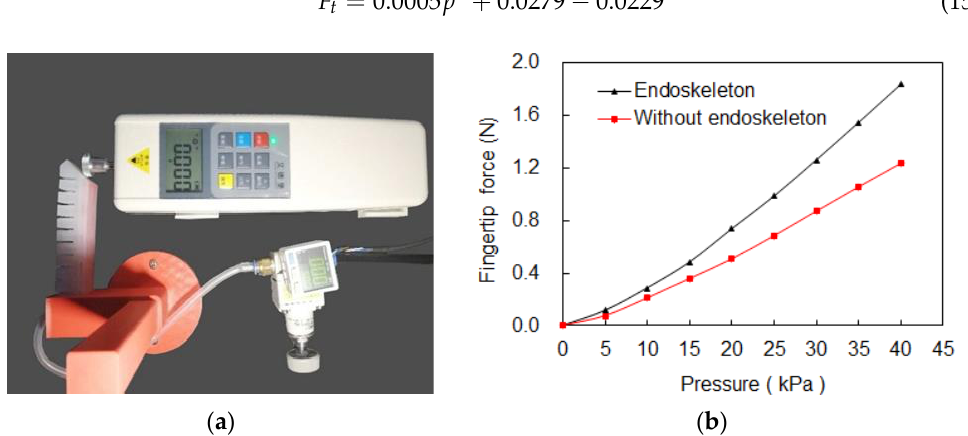
Figure 13. Fingertip force testing platform. ( a ) Experiment layout for force measurement. ( b ) Com- parison chart with or without endoskeleton air pressure and fingertip force.